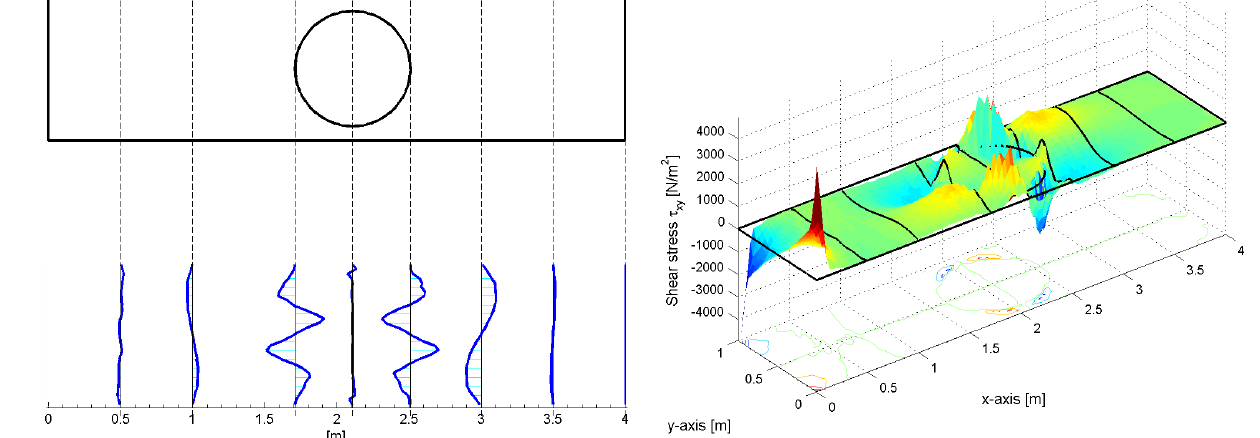
Figure 18: Plot of the shear stresses τ xy along some significant cross-sections (unit of measurement of τ xy : N / m 2 , amplification factor of τ xy : k = 2.0562 · 10 −4 .